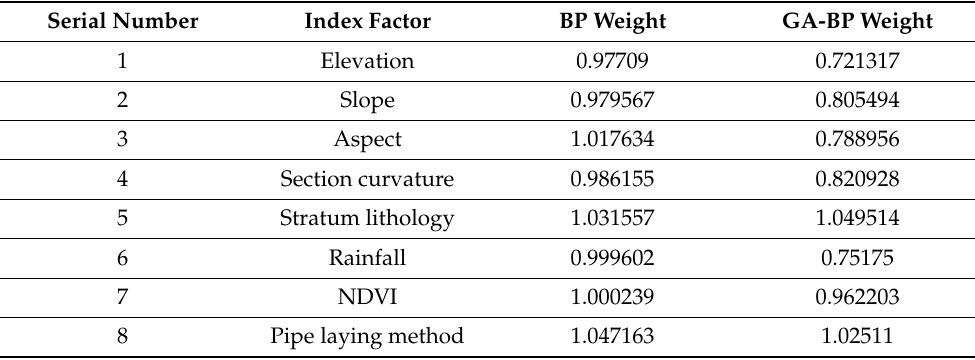
Figure 13. Correlation coefficients of neural network training: ( a ) BP and ( b ) GA-BP. Table 3. Calculated index factor weights.